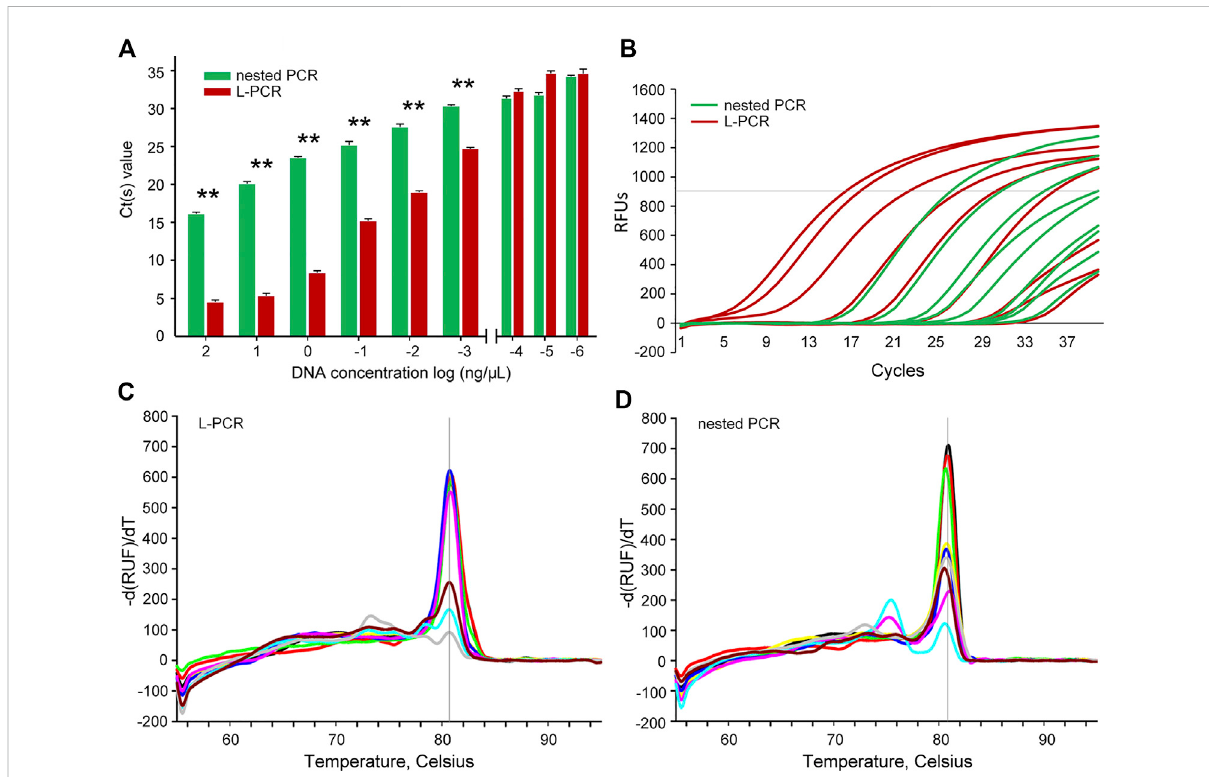
Analytical ef fi ciency and accuracy between the nested PCR and L-PCR assay. (A,B) The Ct value comparison between the nested PCR and the L-PCR assaywith serially dilutedtemplates. (C) The melttemperaturesfor theL-PCR assay. (D) The melttemperaturesfor thenested PCRassay. The asterisk (*) indicates p <